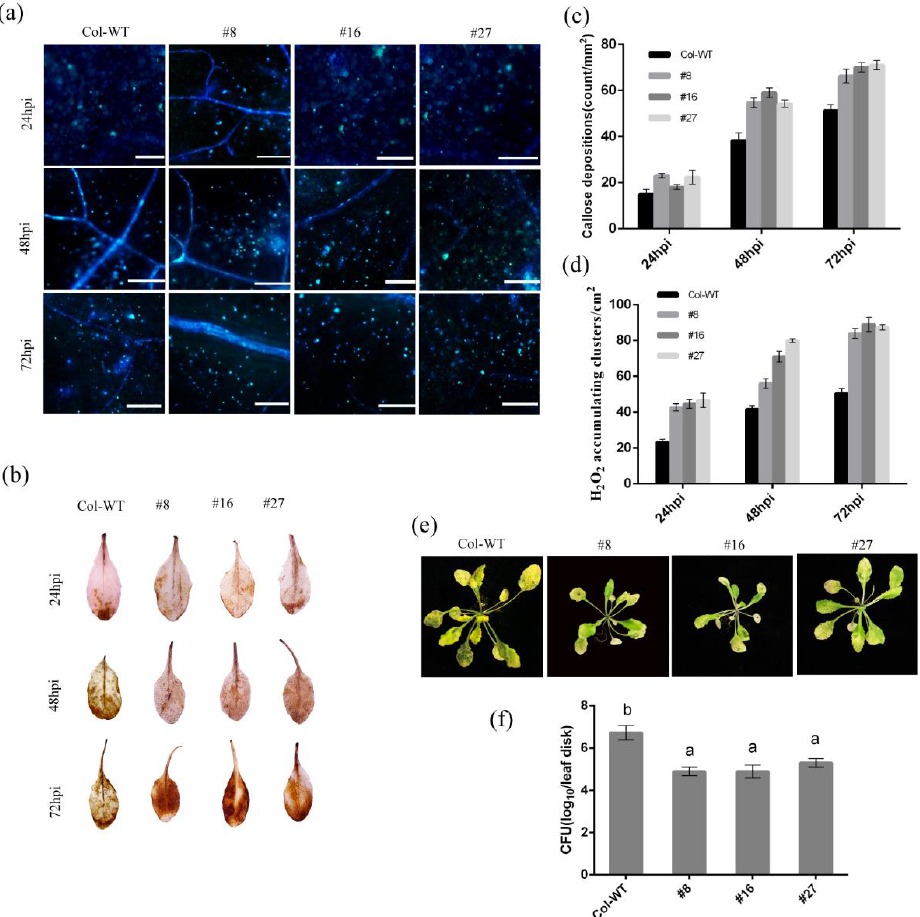
Figure 6. The responses of HbRPW8-a over-expressing lines and Col-WT to bacterial infection. ( a , b ), flg22 induced strong immune response in over-expressing lines ( a ) The callose deposition of Col-WT and over-expressing lines leaves induced by flg22 at 24, 48, 72 hpi; scale bar = 100 µ m. ( b ) ROS accumulation in the overexpressing lines and Col-WT plants at 24, 48, 72 hpi; ( c ) average